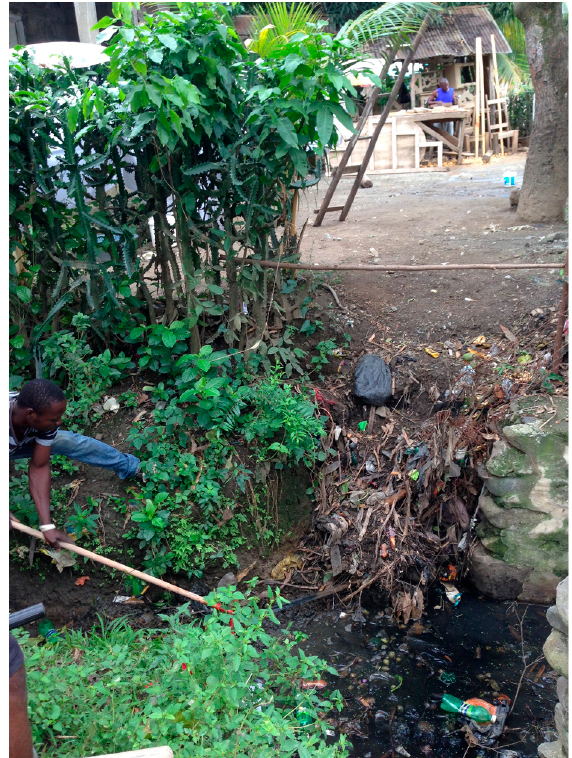
Figure 2. The problem of garbage and canals contributing to the proliferation of Culex mosquitoes, the vector of lymphatic filariasis in Haiti.